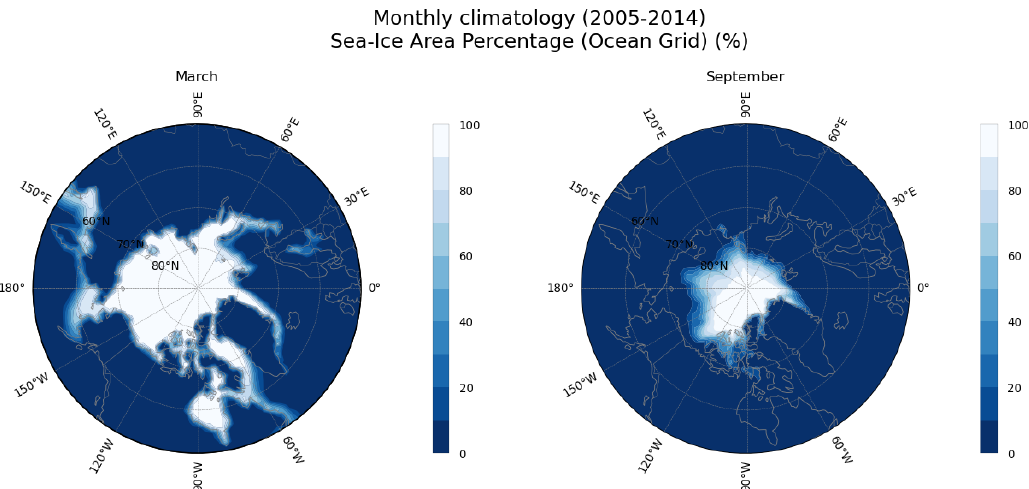
Figure 7. March and September Arctic sea ice concentration from IPSL-CM6 averaged over 2005 to 2014. The simulation shown here follows the CMIP6 AMIP